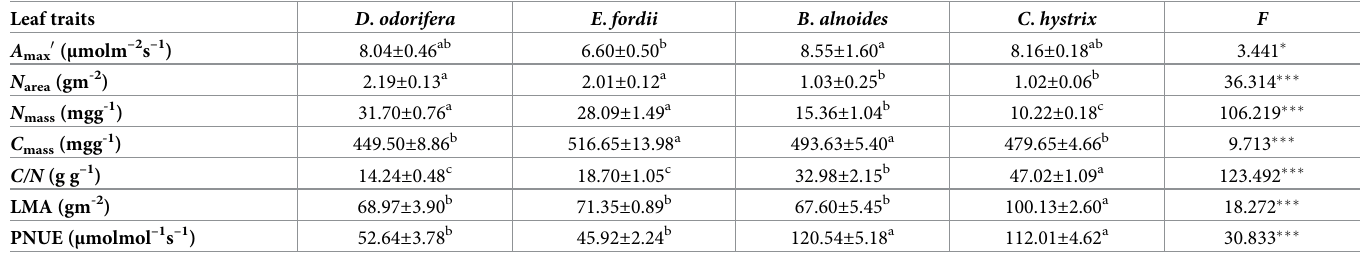
Table 1. Light-saturated photosynthesis ( A max 0 ), leaf N content per area ( N area ), leaf N content per mass ( N mass ), leaf C content per mass ( C mass ), C/N ratio, leaf mass per area (LMA), and photosynthetic-N use efficiency (PNUE) in seedling leaves of four